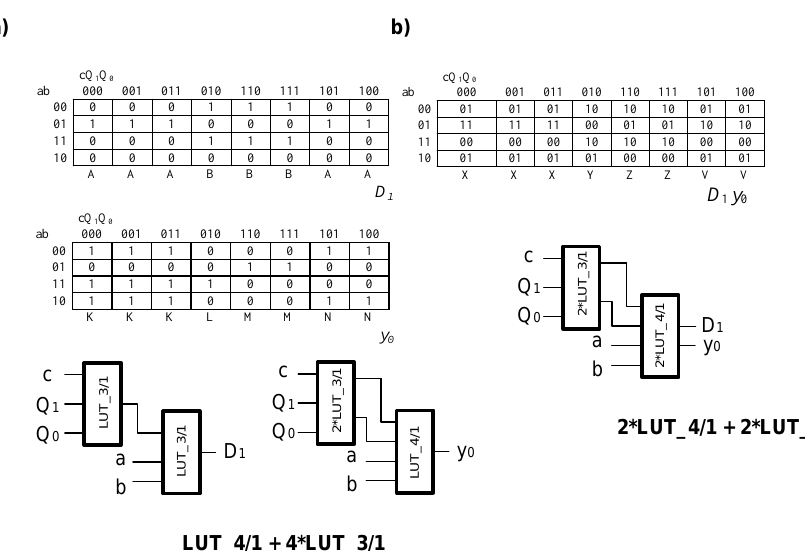
Figure 10. Implementation of a multi-output function that is the result of ( a ) decomposition of each function separately; ( b ) decomposition of multi-output function.